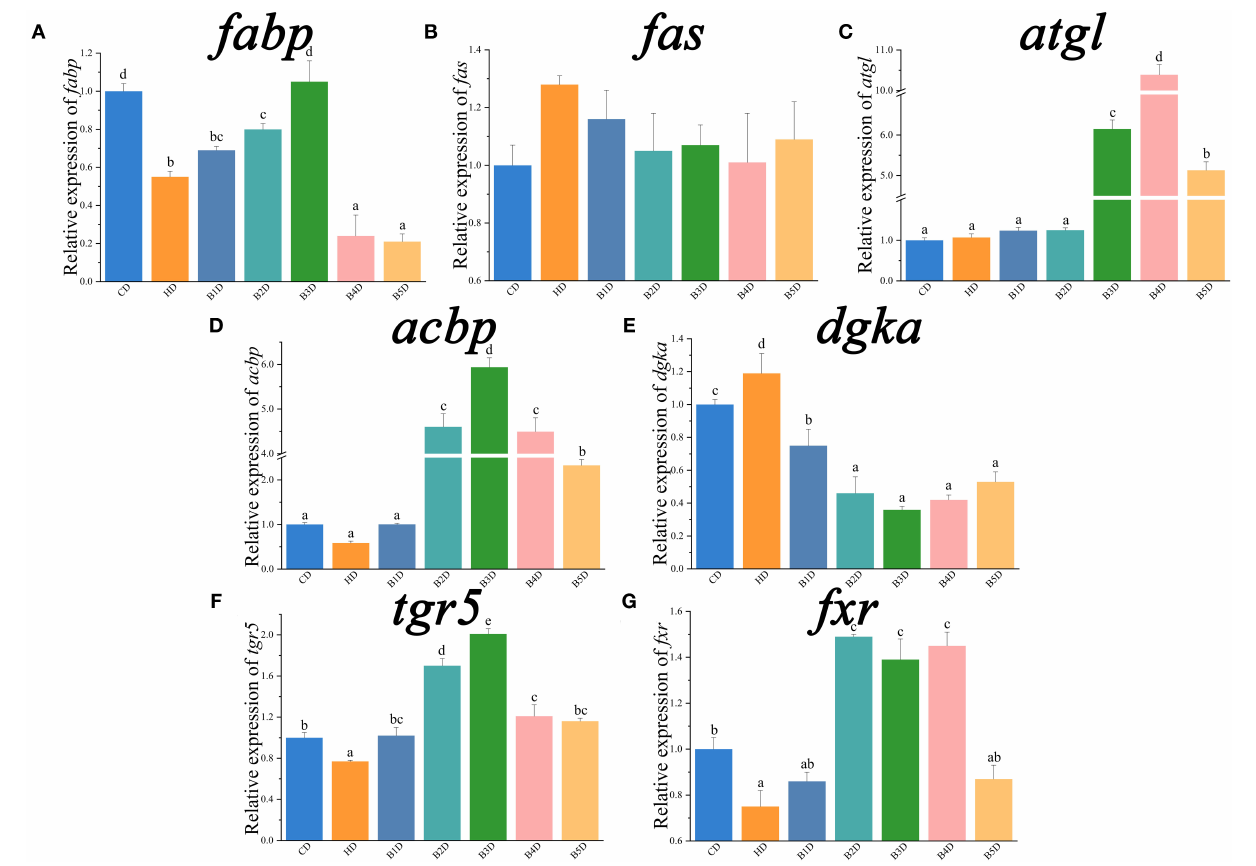
FIGURE 8 | The relative expression of genes associated with lipid metabolism in the liver (part 2). fabp , fatty acid-binding protein; fas , fatty acid synthase; atgl , adipose triglyceride lipase; acbp , acyl-CoA binding protein; dgka , diacylglycerol kinase alpha; tgr5 , G protein-coupled bile acid receptor 1; fxr , farnesoid X receptor. Data are normalized to 18s and β -actin as the reference genes and presented as a fold change in relation to the CD ( n = 6). Values are presented as means with SD, where significant ( p < 0.05) differences between groups are indicated by different